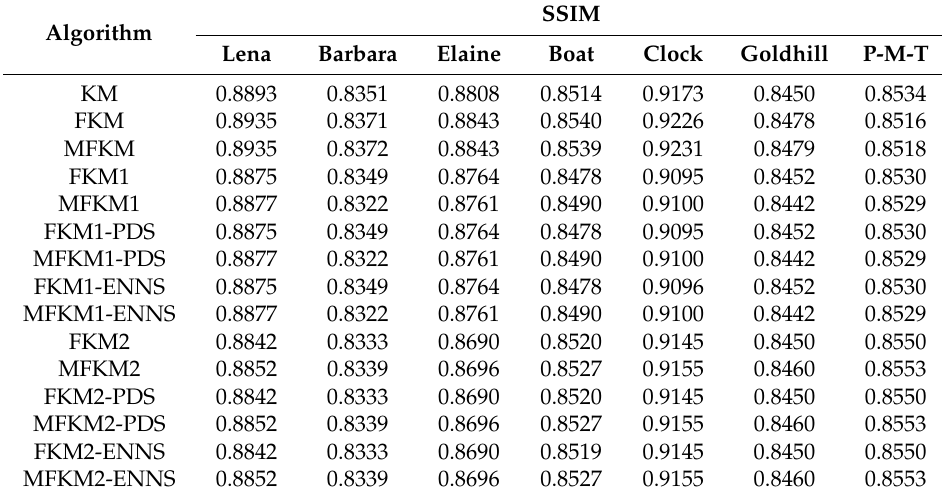
Table 13. SSIM for images Lena, Barbara Elaine, Boat, Clock, Goldhill and P-M-T, using N = 256.